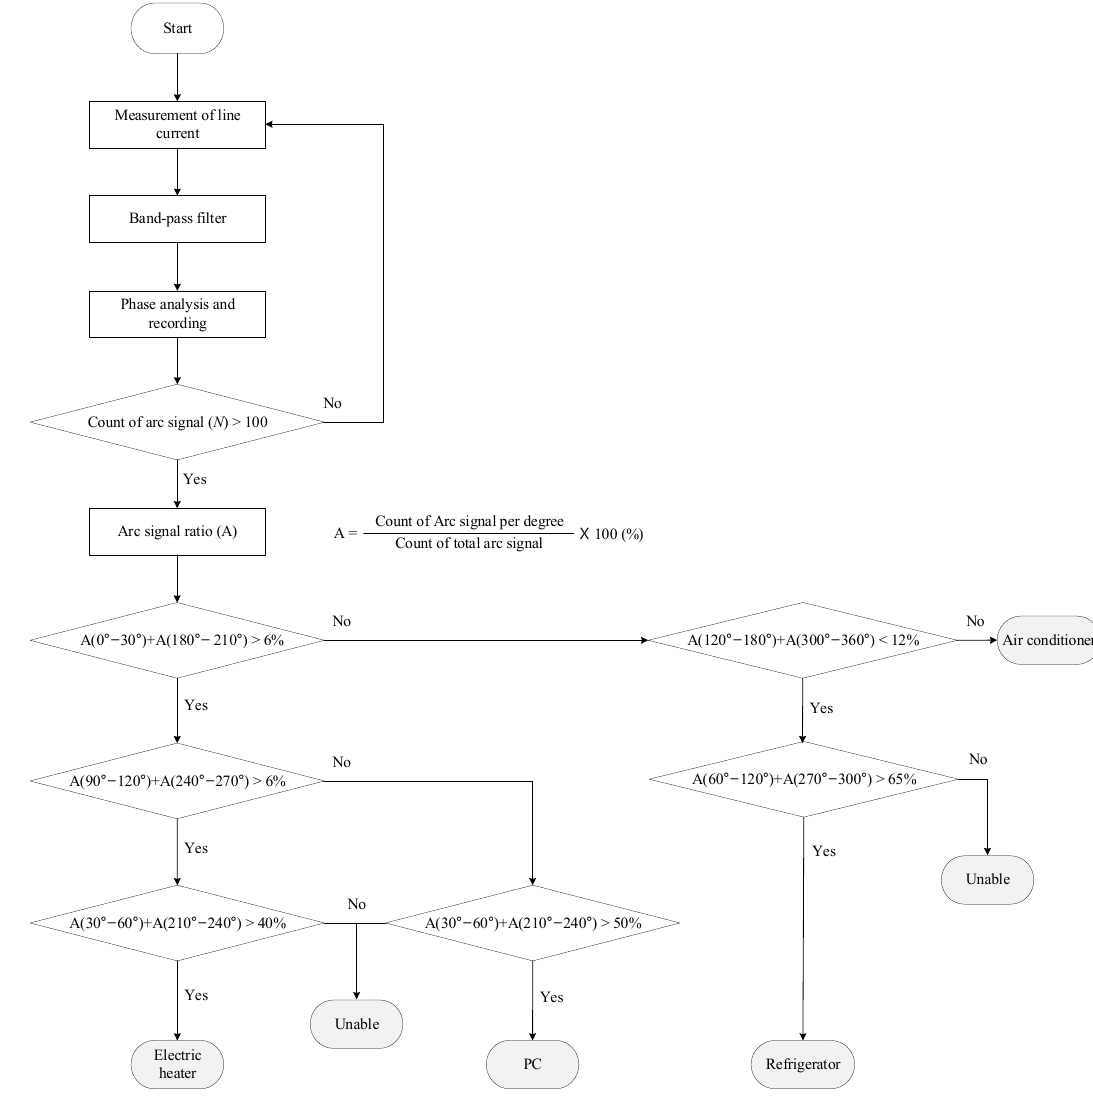
Figure 9. Flowchart of PRSA algorithm.